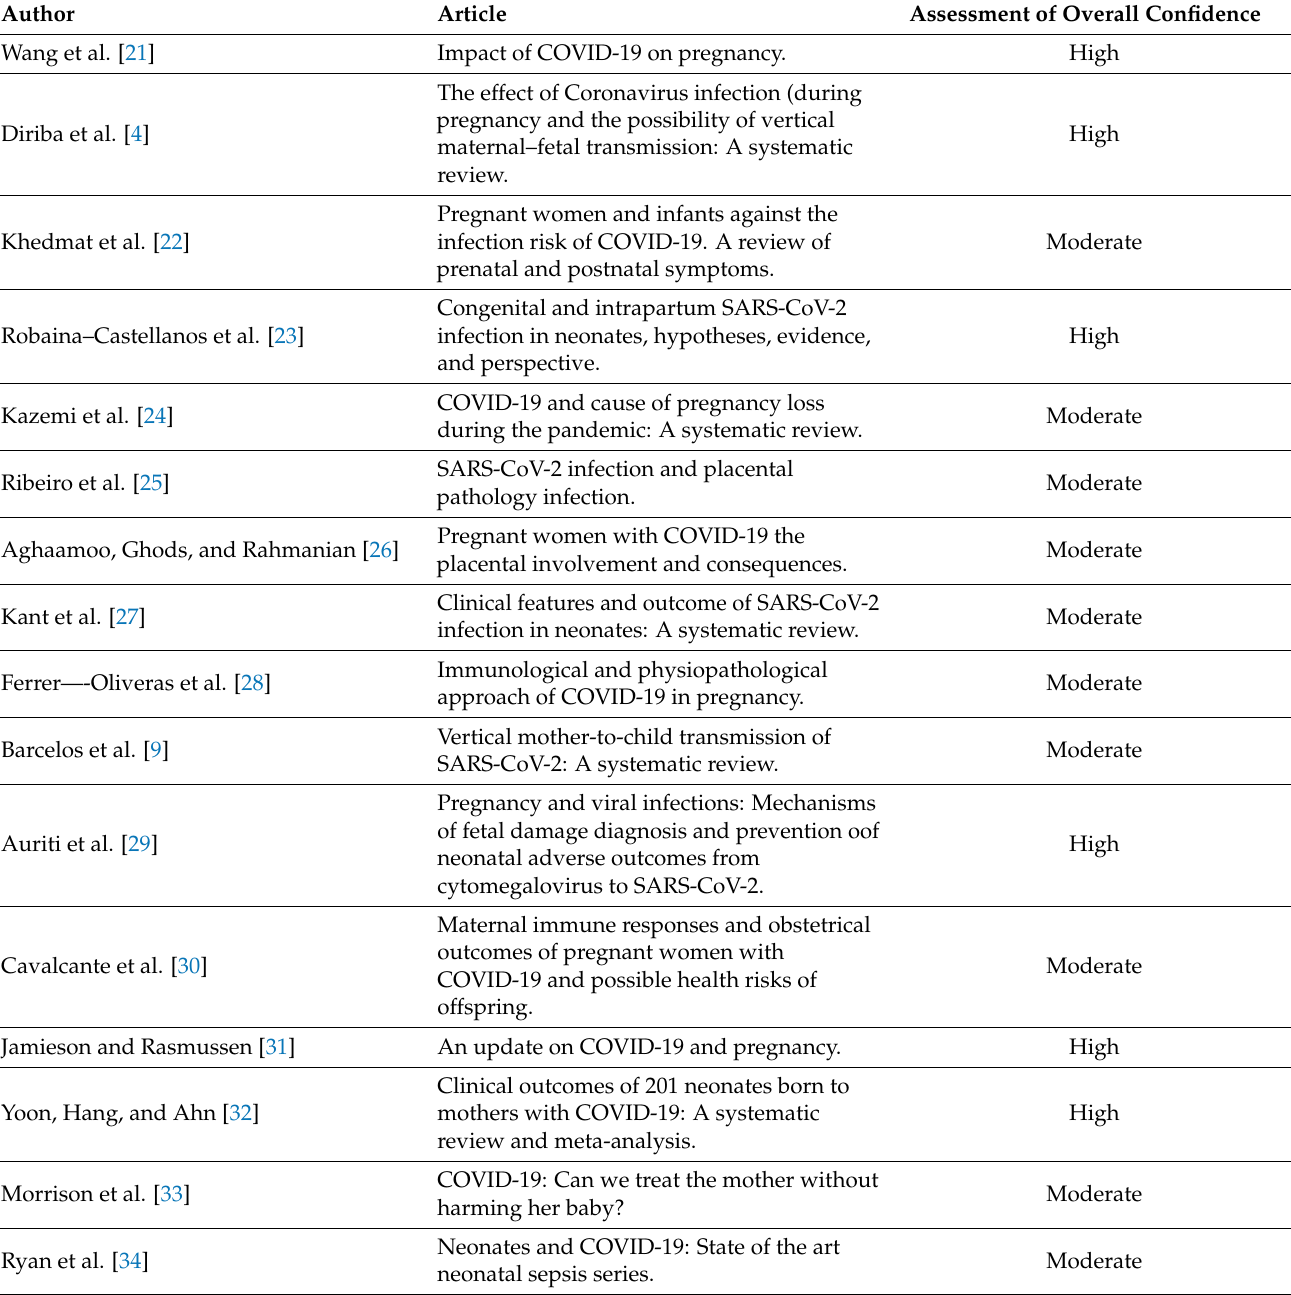
Table 3. Methodological assessment according to the AMSTAR-2